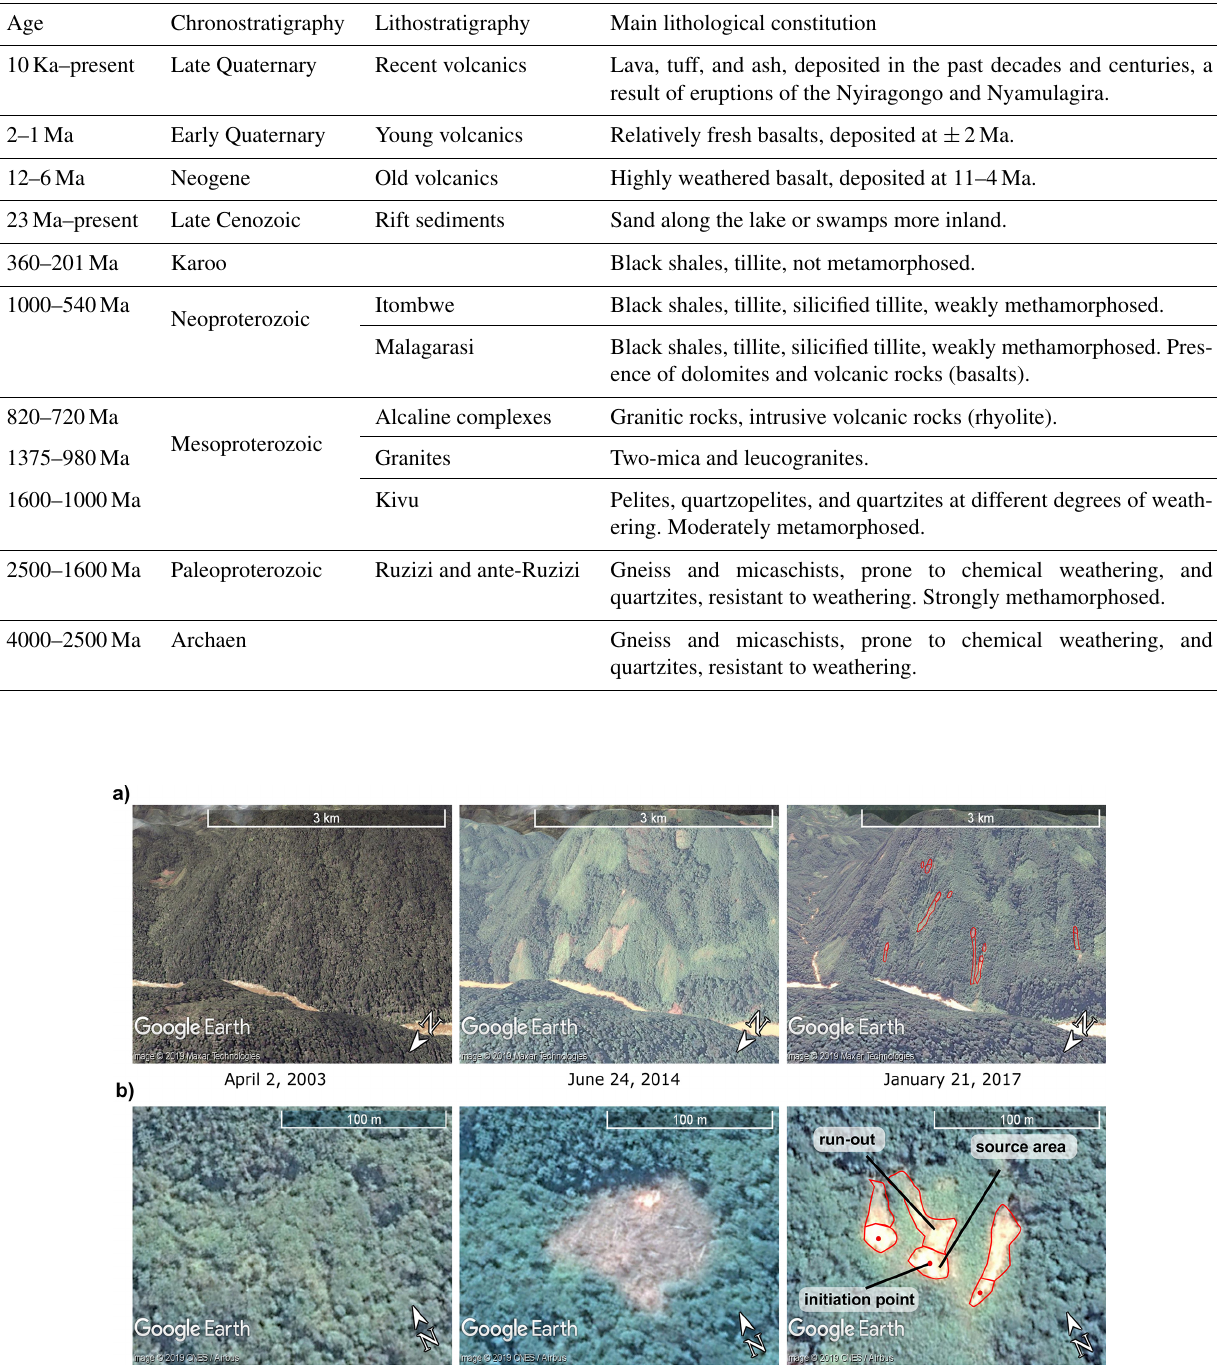
Table 1. Lithostratigraphical units in the NTK rift as presented by Depicker et al. (2020) and based on the work of Laghmouch et al. (2018).